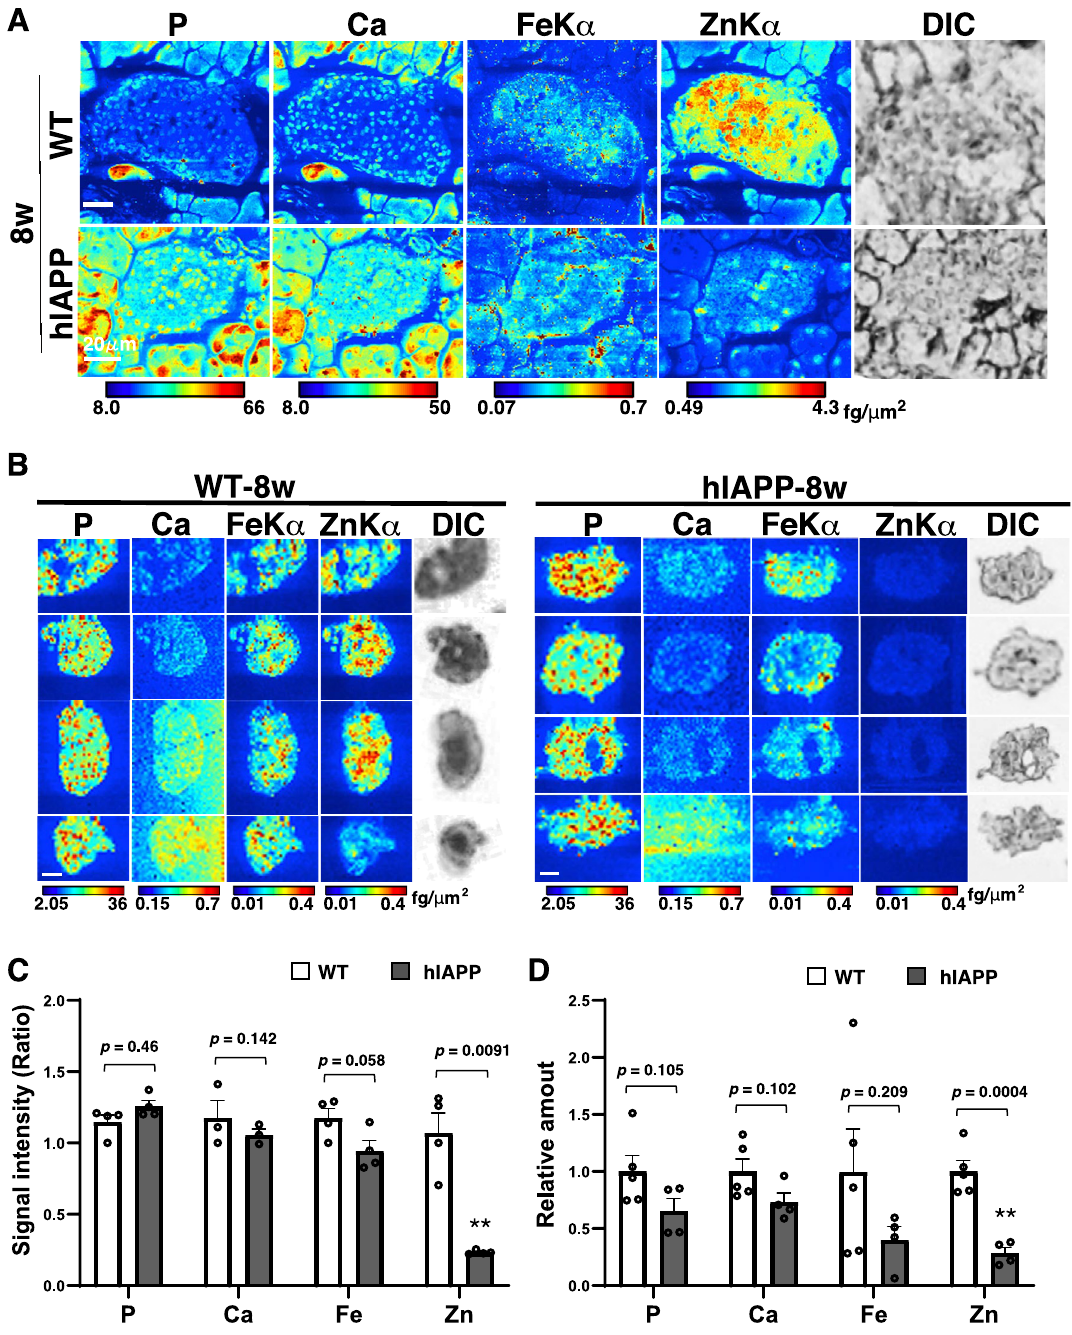
Figure 4. Iron level in islets is partially decreased in 8-week-old hIAPP-Tg mice. ( A ) Mapping images of pancreatic islets from 8-week-old mice. ( B ) Mapping images of isolated islets from 8-week-old mice. Color bar, femtograms per square micrometer; DIC: differential interference contrast image; Scale bar, 20 µm. ( C ) Quantification of signal intensities in ( B ). ( D ) Relative amounts of each element in isolated islets were measured using ICP-MS (n = 5,4 for each genotype). WT: WT mice, hIAPP: hIAPP-Tg mice, Data are shown as means ± SEM. ** p < 0.01 (WT vs. WT mice (Fig. 7A and B, left panels). Maximal respiration (Max Res) induced by the addition of the uncoupler FCCP was upregulated in 5-week-old hIAPP-Tg mice, which might be due to the upregulation of compensation machinery for hIAPP toxicity (Fig. 7B, left panel). These results suggest that changes in both iron and/or zinc dynamics in pancreatic islets may affect Acute Res in the islets.